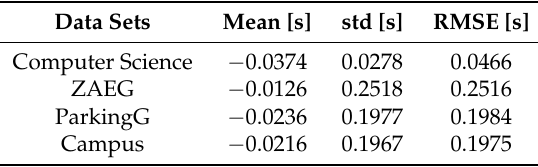
Table 2. Time calibration